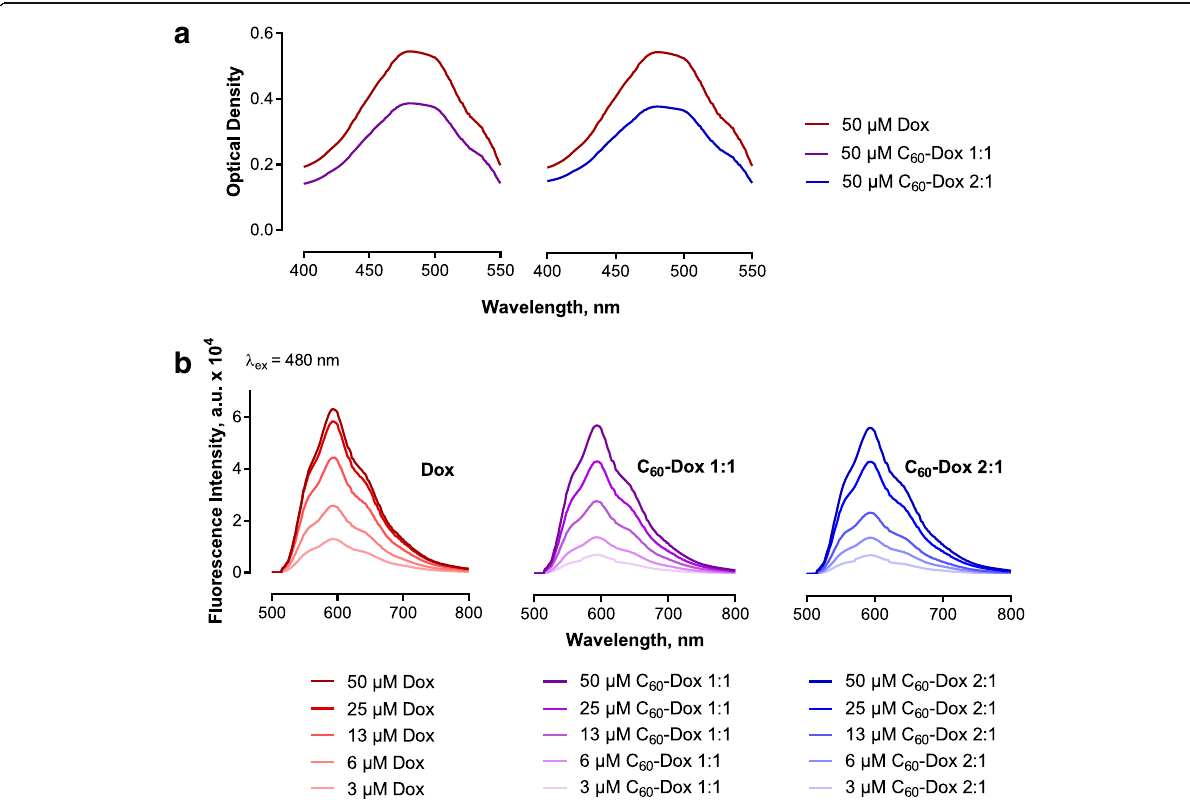
Fig. 2 Optical characterization of complexes. Optical density spectra of free Dox and C 60 -Dox complexes ( a ). Fluorescence emission spectra of free Dox and C 60 -Dox complexes at Dox-equivalent concentration from 3 to 50 μ M ( b ); a.u. arbitrary